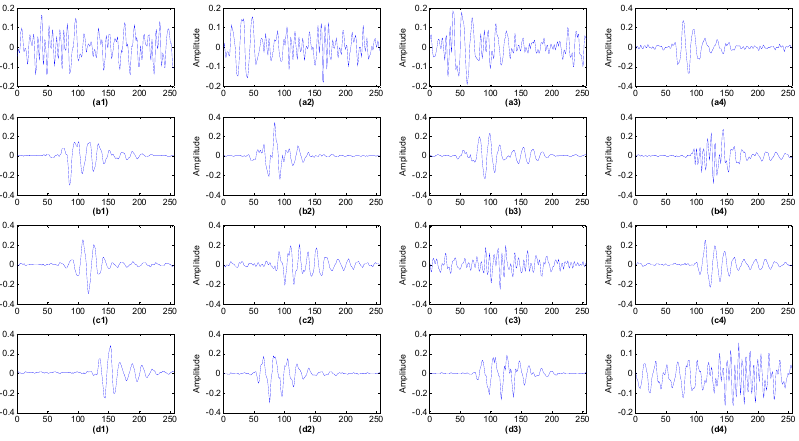
Figure 4. The learned basis functions corresponding to four running states: ( a1 – a4 ) normal; ( b1 – b4 ) inner race fault; ( c1 – c4 ) rolling element fault; ( d1 – d4 ) outer race fault.